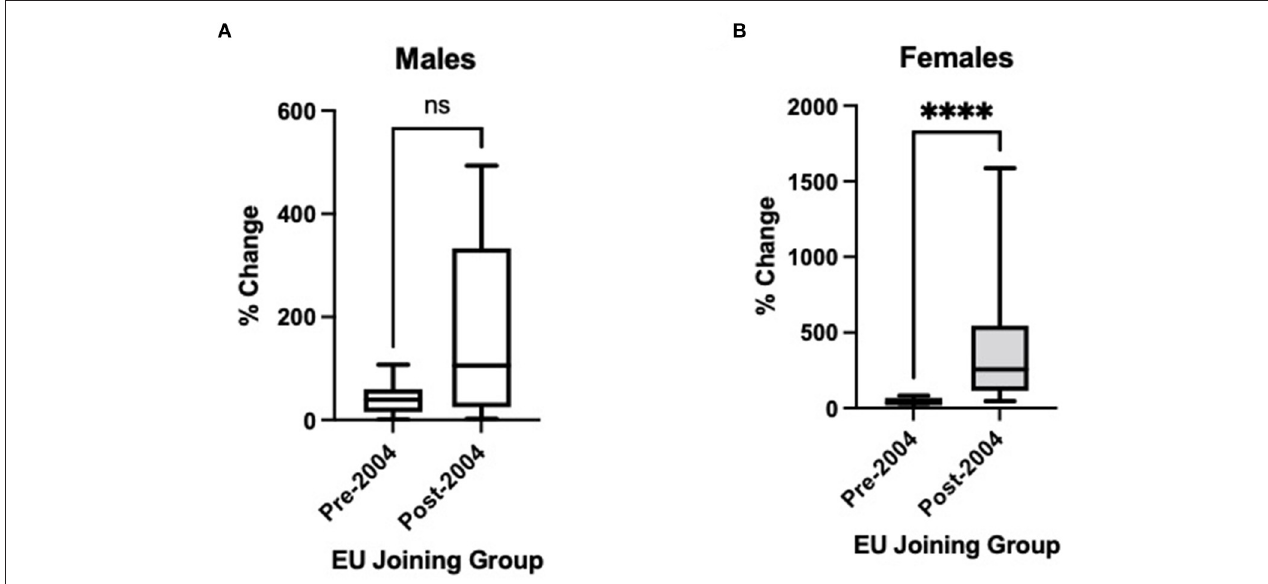
FIGURE 1 | Changes in age-standardised death certification rates per 1,000,000 for countries joining the European Union (EU) before 2004 and 2004 or later, 2000 to 2017, for non-rheumatic aortic stenosis for those aged > 45 years in (A) males and (B) females. Pre-2004 countries: Austria, Belgium, Denmark, Finland, France, Germany, Italy, Netherlands, Portugal, Spain, Sweden, and the United Kingdom. Post-2004 countries: Bulgaria, Croatia, Czech Republic, Estonia, Hungary, Latvia, Lithuania, Poland, Romania, Slovakia, and Slovenia. Rather than 2000–2017, the following intervals are used owing to data availability: Bulgaria 2005–2015;